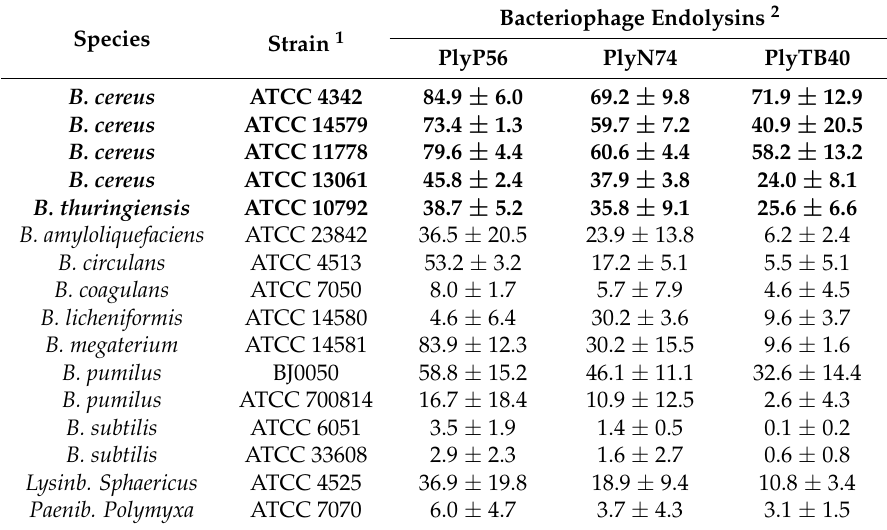
Table 2. Relative lytic activity of Bacillus bacteriophage